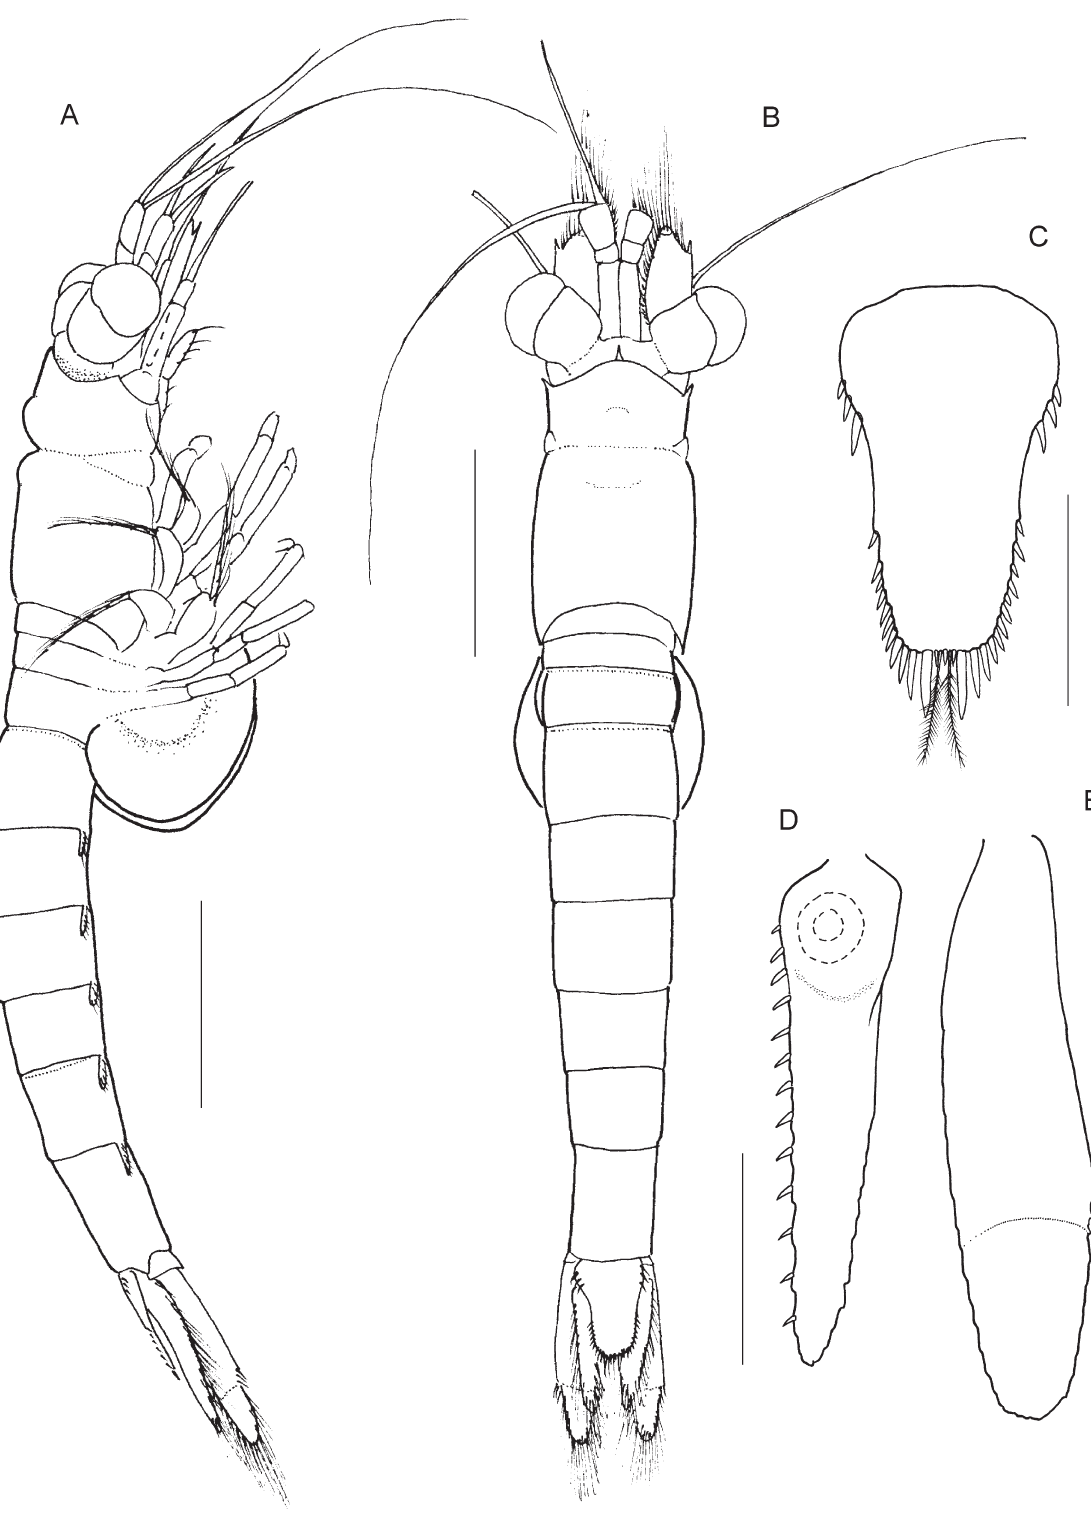
Fig. 23. Siriella tabaniocula sp. nov., holotype, ♀, length 6 mm, Ningaloo Reef, Western Australia. A . Habitus, lateral view. B . Habitus, dorsal view. C . Telson. D . Uropodal endopod, dorsal view. E . Uropodal exopod, dorsal view. Scale bars: A–B = 1 mm; C–E = 0.25